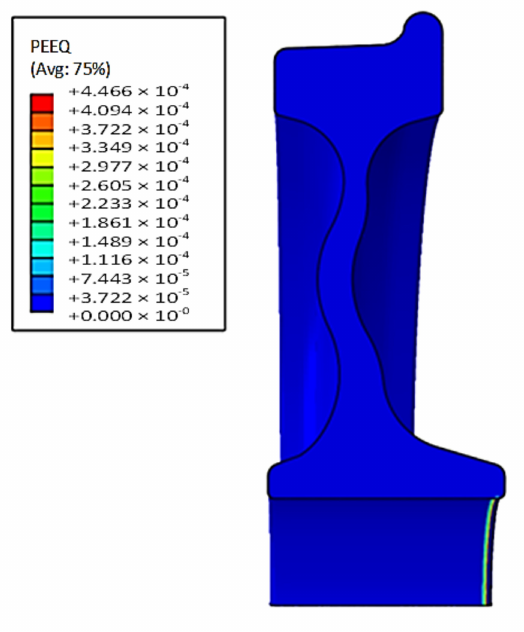
Figure 16. Equivalent plastic strain on the